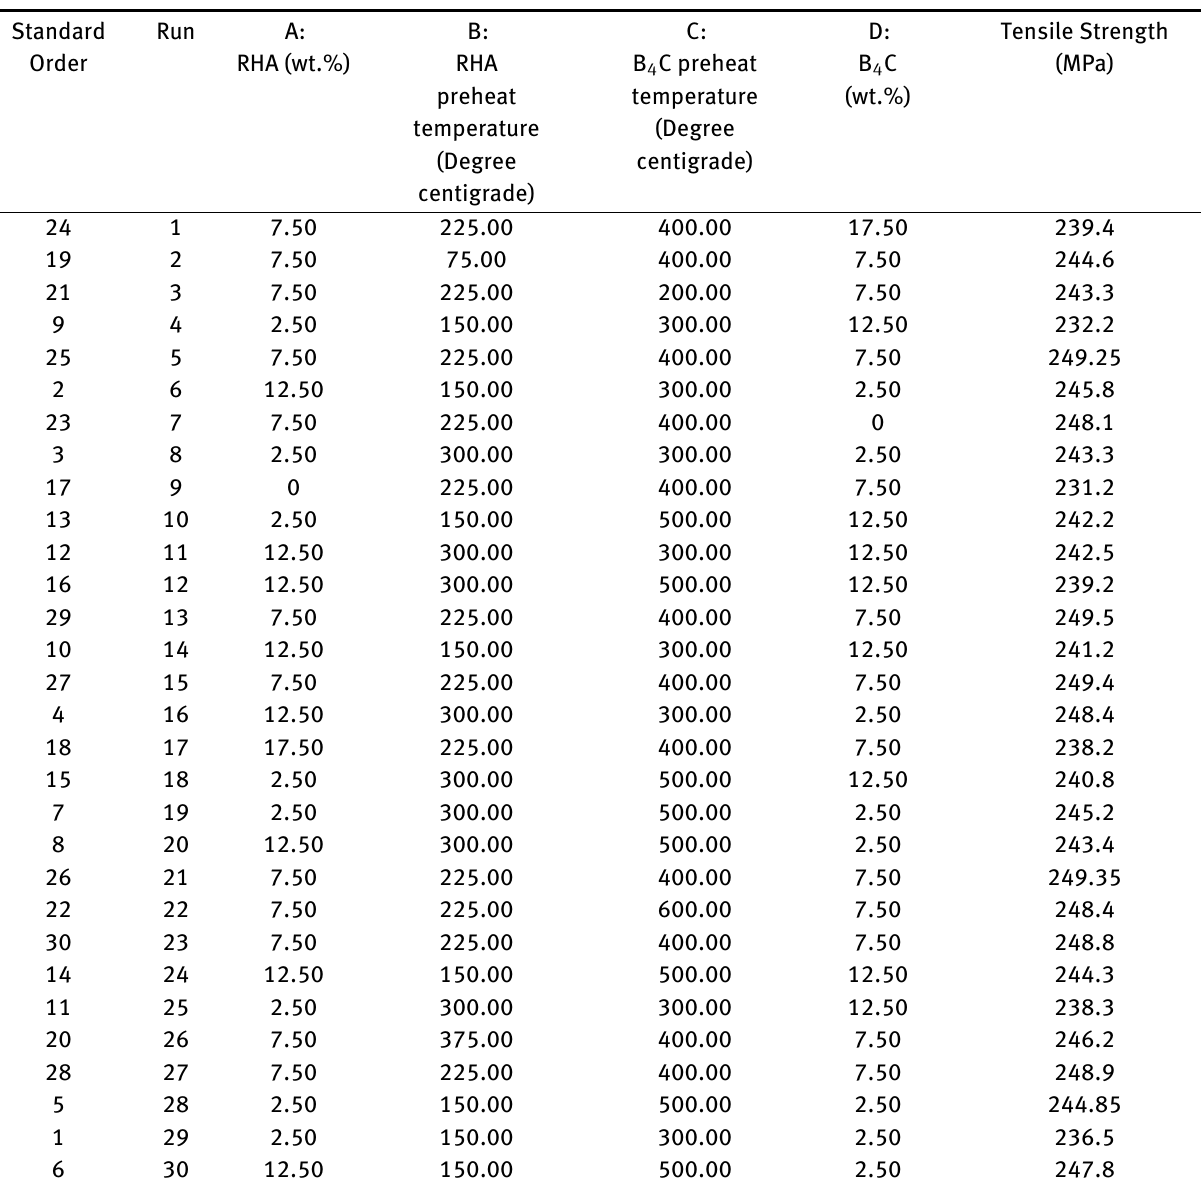
Table 7: Design matrix and experimental